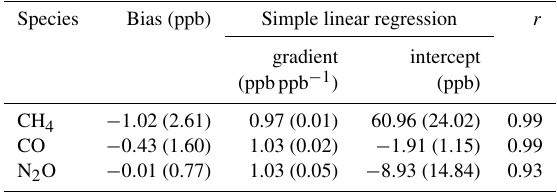
Table 7. FTIR flask comparison results per species. FTIR flask data set biases are listed with the 1 σ standard deviation in brackets. Lin- ear regression fitting parameters and uncertainties (bracketed) are listed in the middle columns. The final column has the Pearson cor- relation coefficient ( r ) of the fitted scatter plot